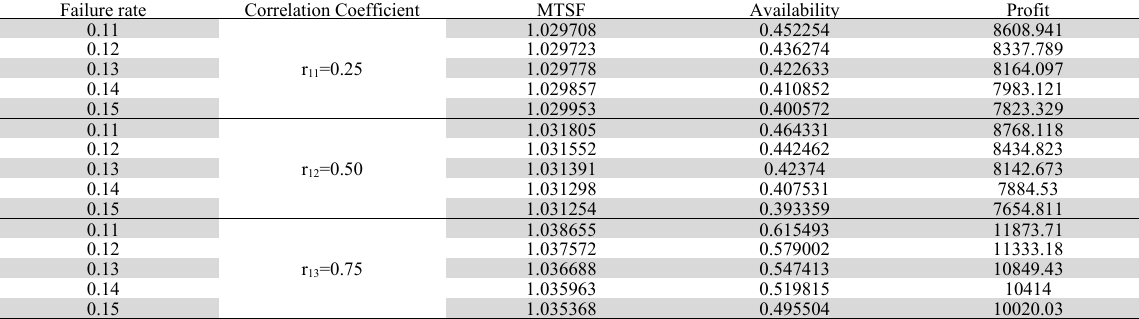
The results of different values of MTSF, Availability and Profit under different failure